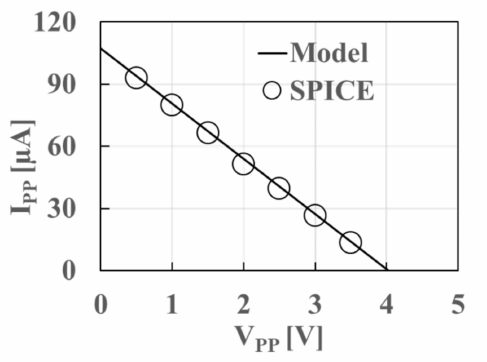
Figure 14. V PP – I PP of CP2 operating with TEG whose V OC and R TEG are 1.6 V and 2.5 k Ω . When the parasitic resistance of the interconnection to connect multiple TEG units is not negligibly small or the oscillator cell consumes substantial power, proper corrections would need to be done to accurately design the TEG–CP system with minimum